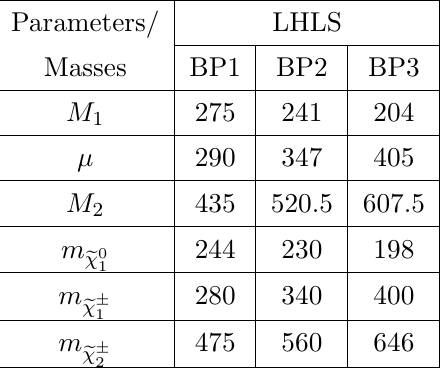
Table 5 . BPs consistent with the LHC and a (cid:22) constraints as derived in section 5. All masses and mass parameters are in GeV.